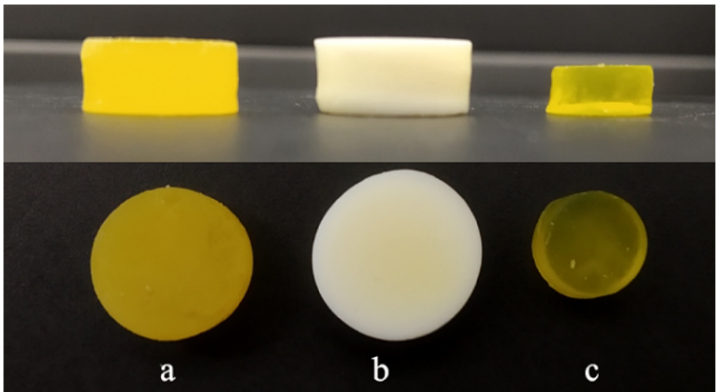
Figure 11. Side and top views of MEB-loaded tablets: after printing ( a ), directly after dissolution test ( b ), and after dissolution test and drying at room temperature ( c ).